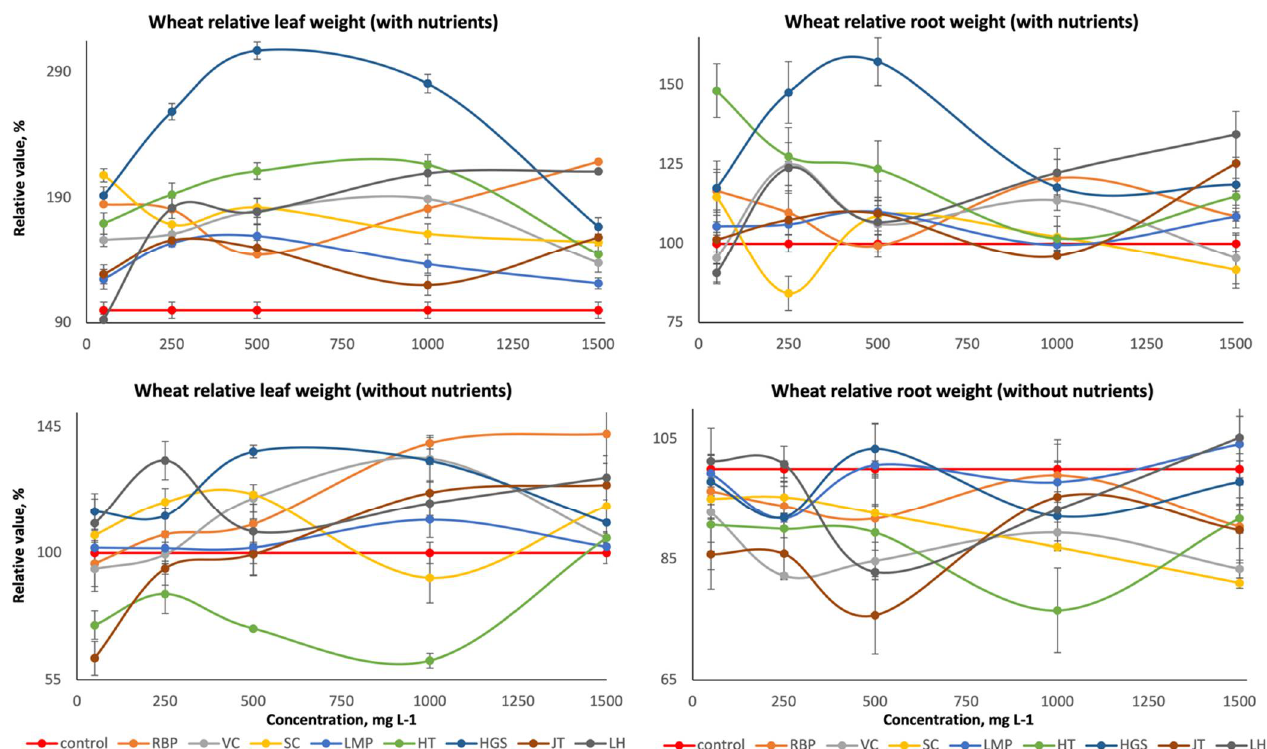
Figure 6. Relative changes in winter wheat ( Triticum aestivum ) shoot and root weight over a concentration range of HS solutions of different origins, with and without added nutrient solution. RBP = raised bog peat, VC = vermicompost, SC = soil compost, LMP = low moor peat, HT = Humin Tech potassium humate, HGS = Humic Growth Solutions potassium humate, JT = Jin Tai FA, LH = Lignohumate HS.